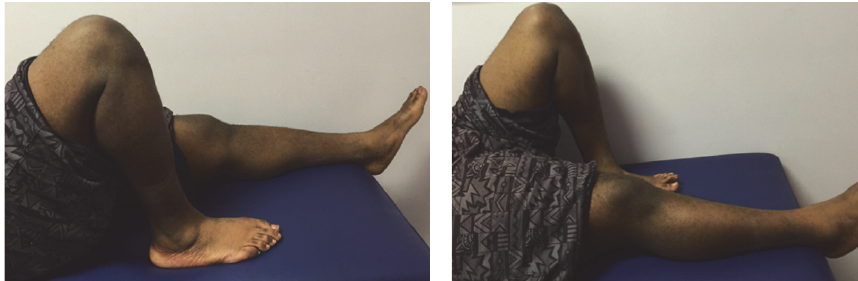
Figure 3: Clinical photos 2 years postoperatively showing full range of motion (0–120